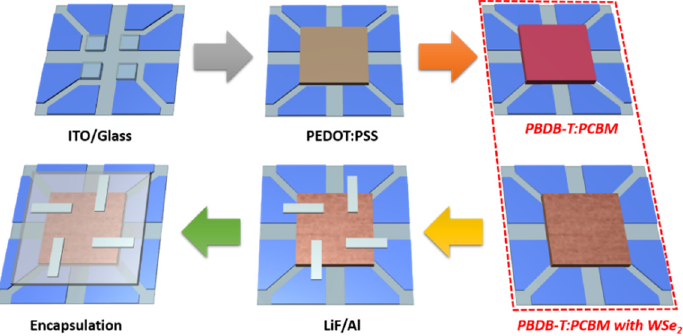
Figure 1. Schematic process for the fabrication of pure and WSe 2 NSs-suspended PBDB-T:PCBM active layer comprising a BHJ device.